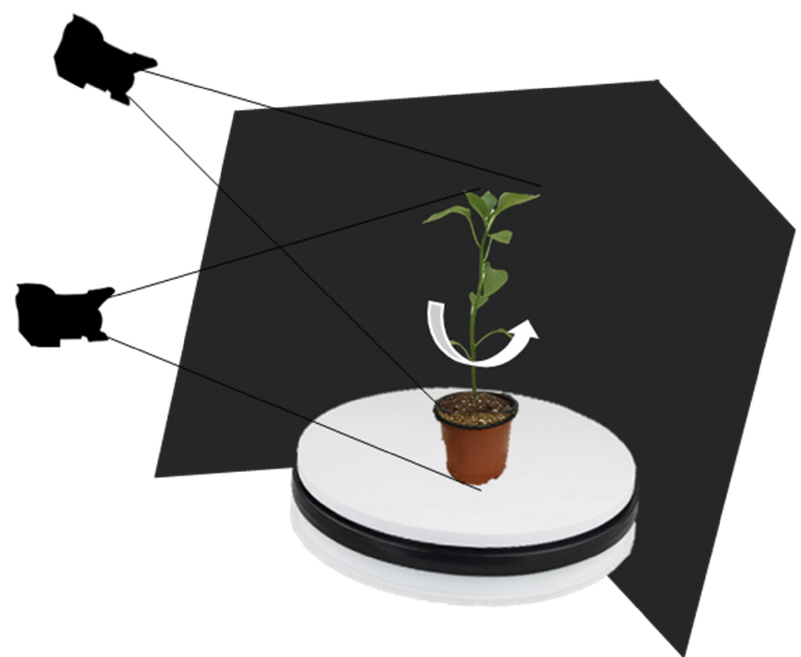
Figure 1. Experimental environment in which various angle images of crops are acquired. Table 1. Kinect v2 specifications